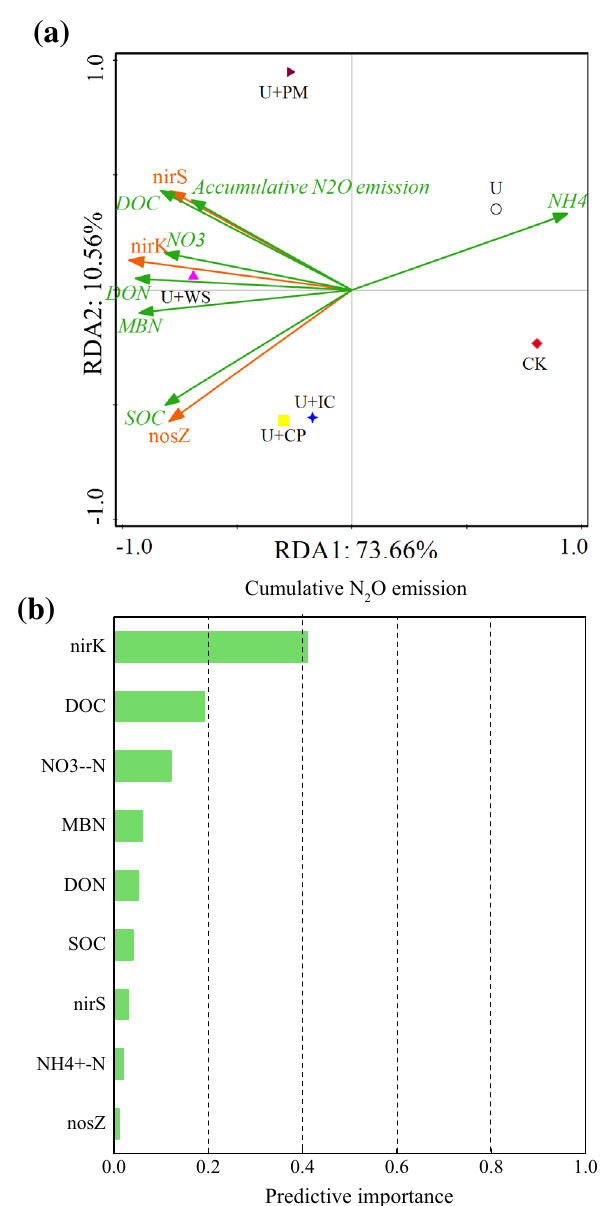
Figure 3. Principal component analysis (PCA) of soil properties, cumulative N 2 O emission and abundance of denitrification genes ( a ); predictive importance of denitrifier gens abundance, and soil properties on cumulative N 2 O emission as determined by automatic linear modeling ( b ) ( DOC dissolved organic carbon, MBN microbial biomass carbon, DON dissolved organic nitrogen, SOC soil organic carbon, CK no urea and OAs, U urea, U + WS urea plus wheat straw, U + PM urea plus pig manure, U + CP urea plus compost, U + IC urea plus improved